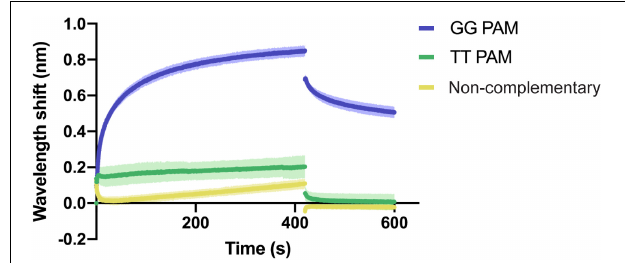
FIGURE 4 | Qualitative analysis of PAM preference by Type I-Fv Cascade. Wavelength shift (nm) generated by the addition of 1.5 µ M of Type I-Fv Cascade from S. putrefaciens CN-32 to dsDNA oligonucleotides containing a spacer matching to the crRNA and either a GG or a TT PAM. The GG PAM is recognized by the complex, while the TT PAM is not recognized, giving shifts similar to that procured by a non-complementary target. Assays were performed in duplicate. The lighter outlines represent the SEM.